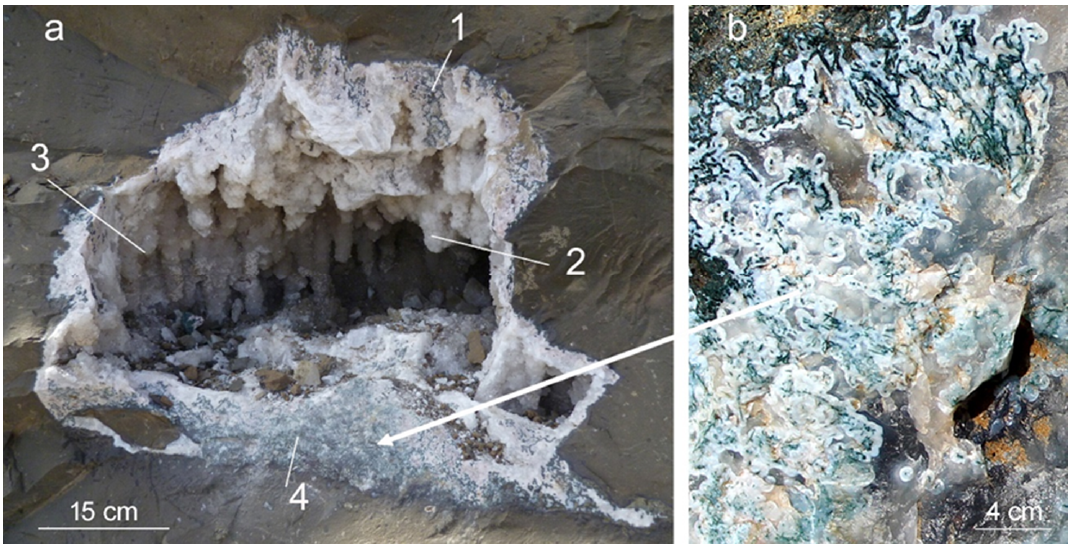
Figure 4. ( a ) Cavity from the flow core in Jalgaon/Savda representing SFF with variable morphology recognizable by the dark green color: (1) zone at the cavity ceiling with random intergrowths embedded in chalcedony; (2) linear SFF showing gravity-controlled growth from the cavity ceiling downwards into the free space; (3) side walls covered with random intergrowths and gravity controlled SFF; (4) cavity bottom with masses of irregular SFF embedded in chalcedony. ( b ) Close-up showing dark green filamentous structures embedded in chalcedony.